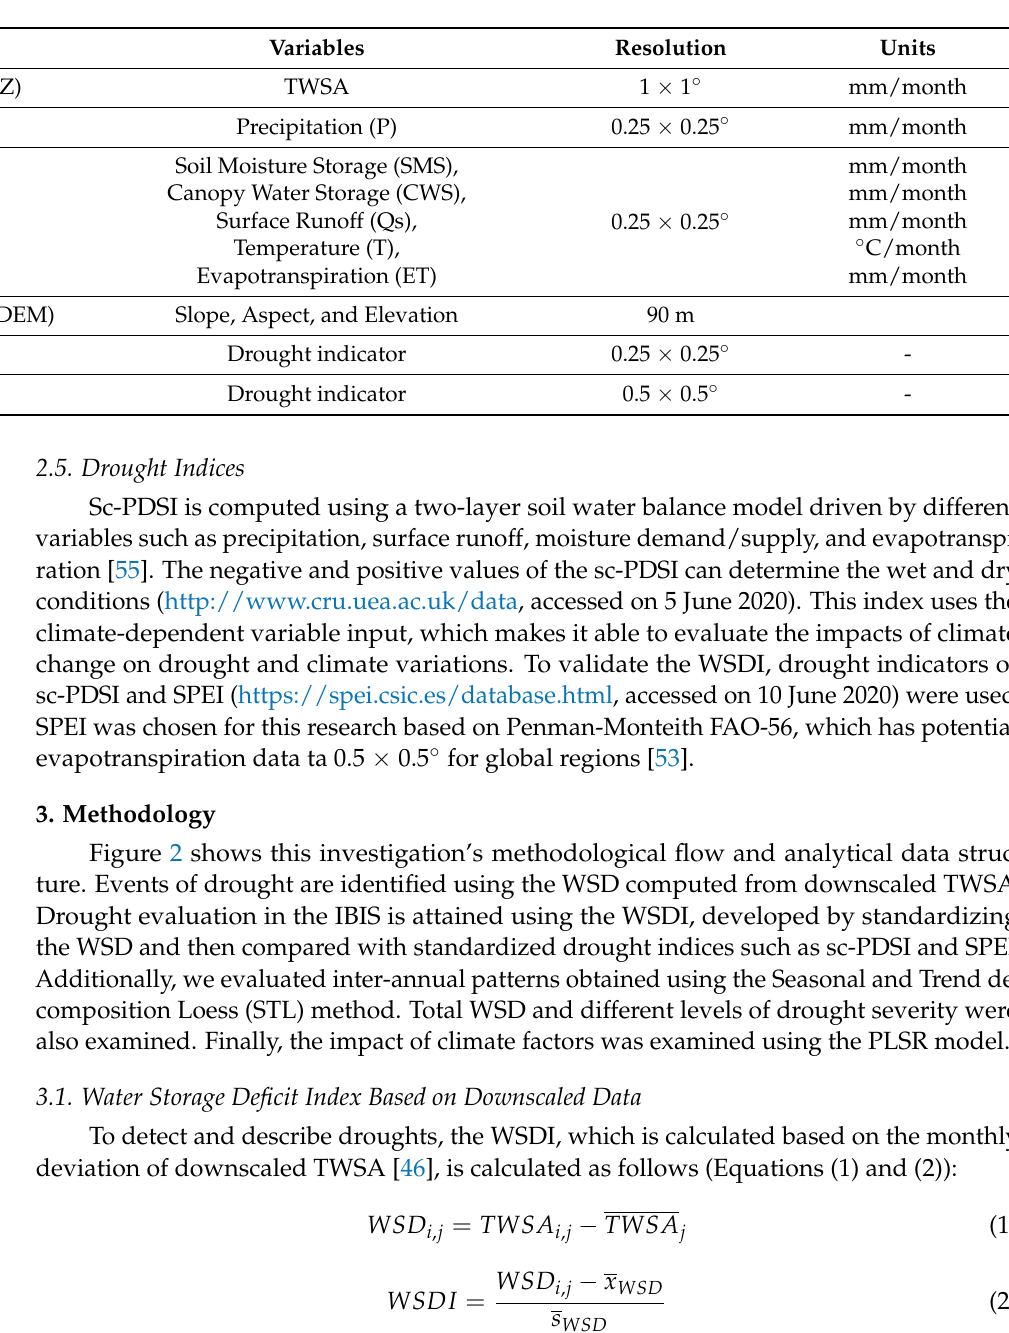
Table 1. Concise information on the characteristics of the used